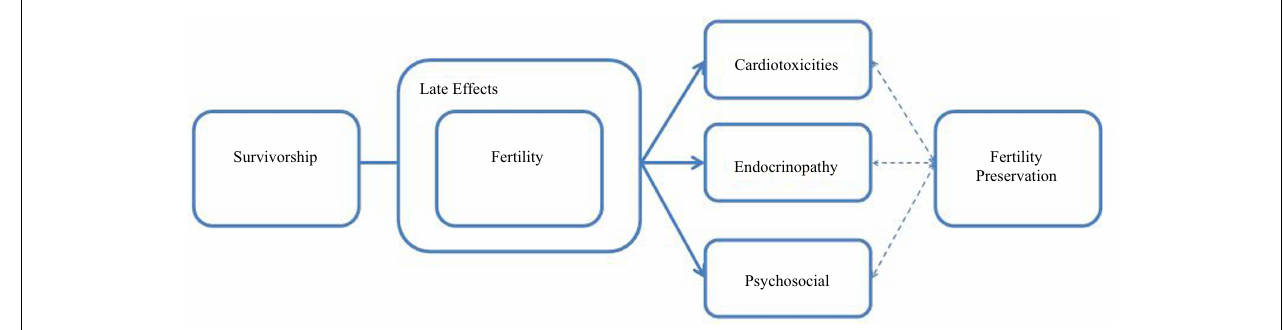
FIGURE 1 | Relationship of fertility and late effects in survivorship